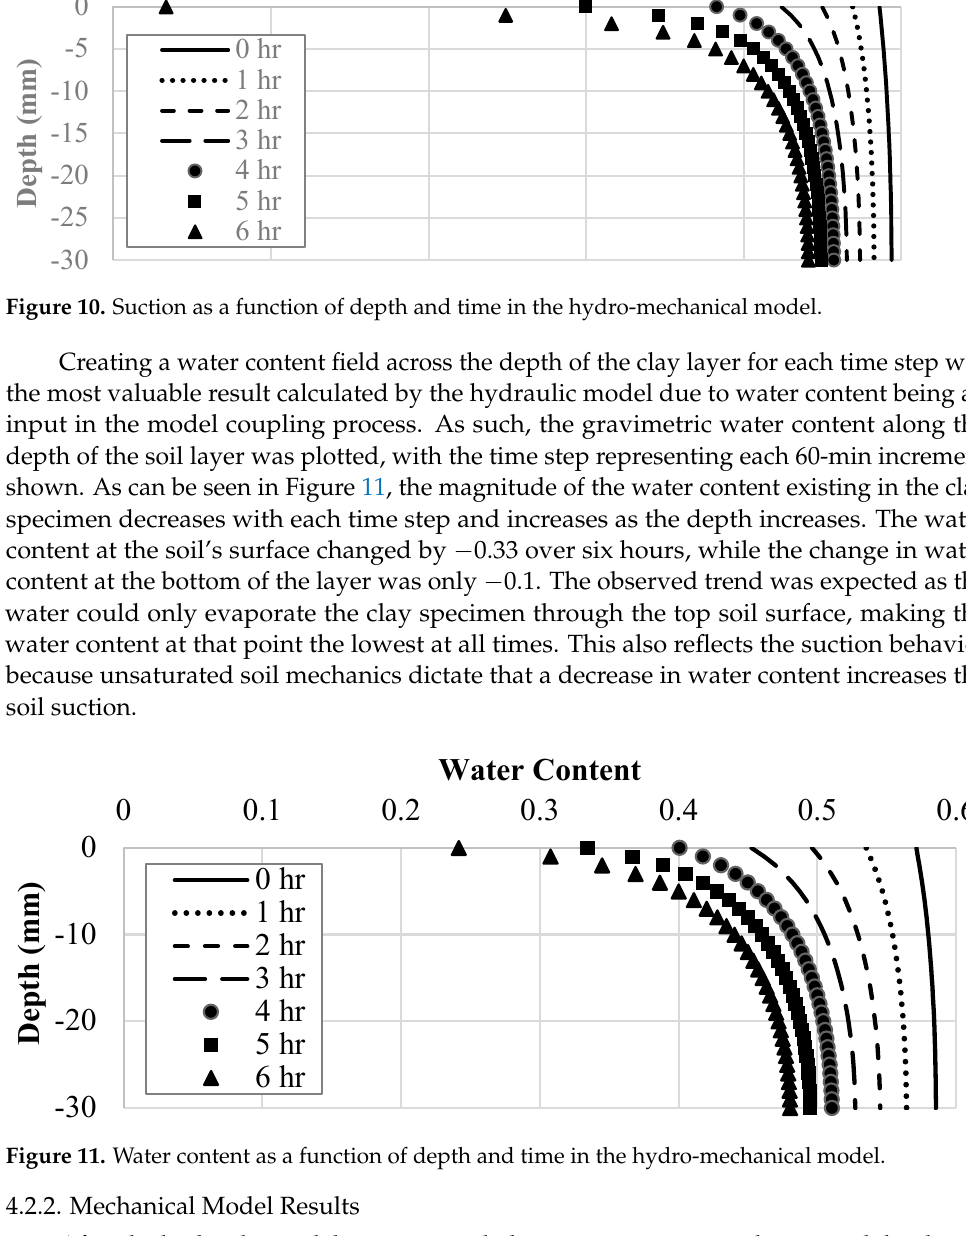
Figure 11. Water content as a function of depth and time in the hydro-mechanical model. After the hydraulic model was executed, the water content at each time and depth was input into the mechanical model for each soil improvement additive. Doing this allowed for the stresses at each point in the model’s profile to be calculated during the six-hour time period. The obtained data were then compared to the soil’s material and interface properties to determine the onset of desiccation cracking at different points in time, depths, and radial distances. Based on the stress formulation for the pre-wall crack scenario, the stresses produced at the center of the soil would always be equal to or greater than at any other point in the clay profile. As a result, this position in the soil layer was considered to be the critical one. Figure 12a shows how the stresses and governing material and interface properties progressed with time for the untreated soil at the center of the soil surface. At the center of the soil specimen, the radial stress and the hoop stress are identical and therefore overlaid in the